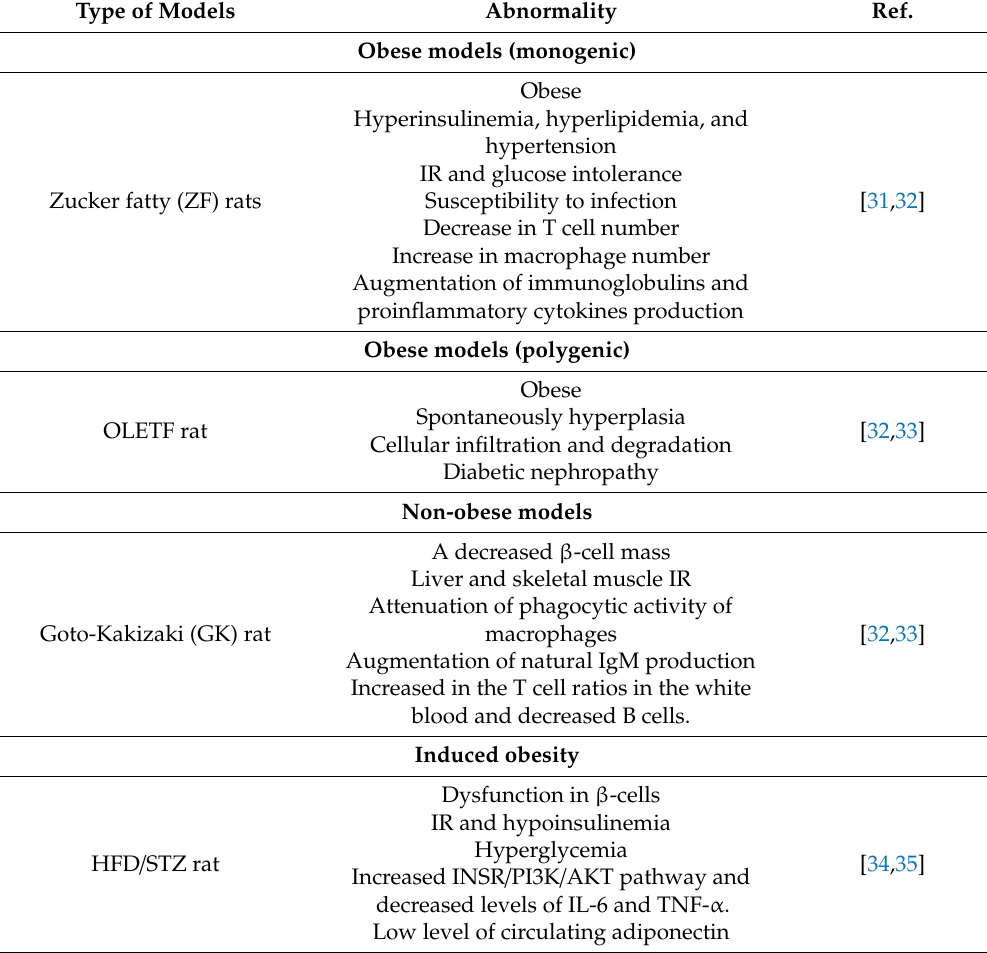
Table 2. Summary of rat models of type 2 diabetes